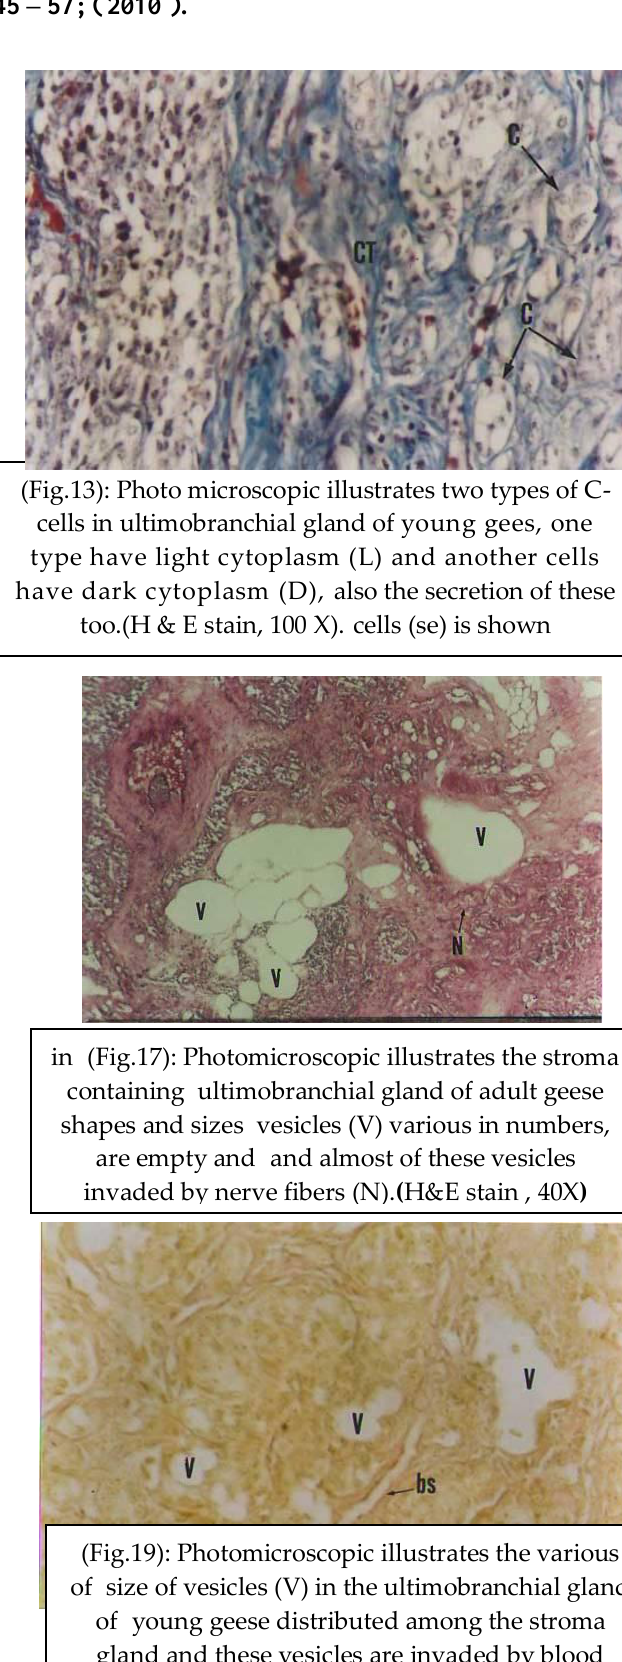
vessels (bv). Van Giesson stain, 40